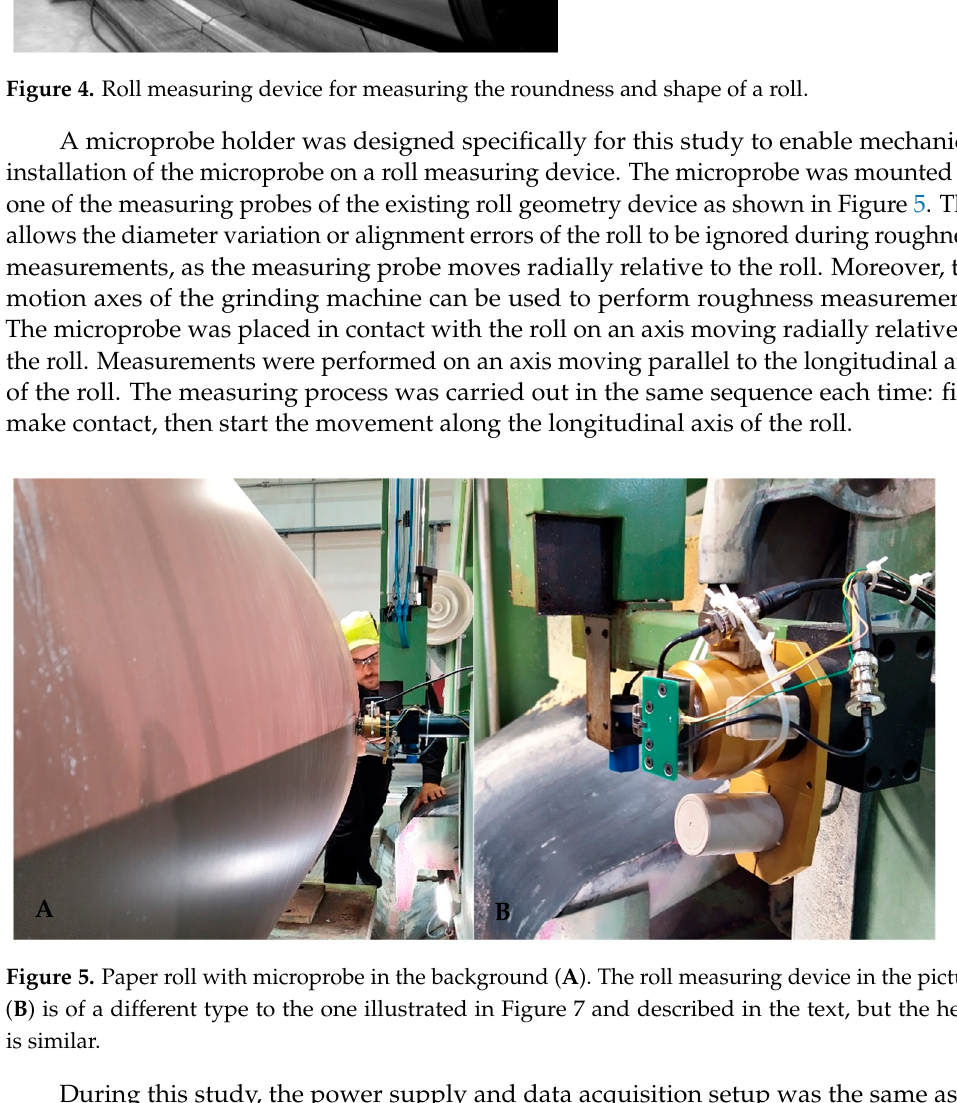
Figure 5. Paper roll with microprobe in the background ( A ). The roll measuring device in the picture ( B ) is of a different type to the one illustrated in Figure 7 and described in the text, but the head is similar.